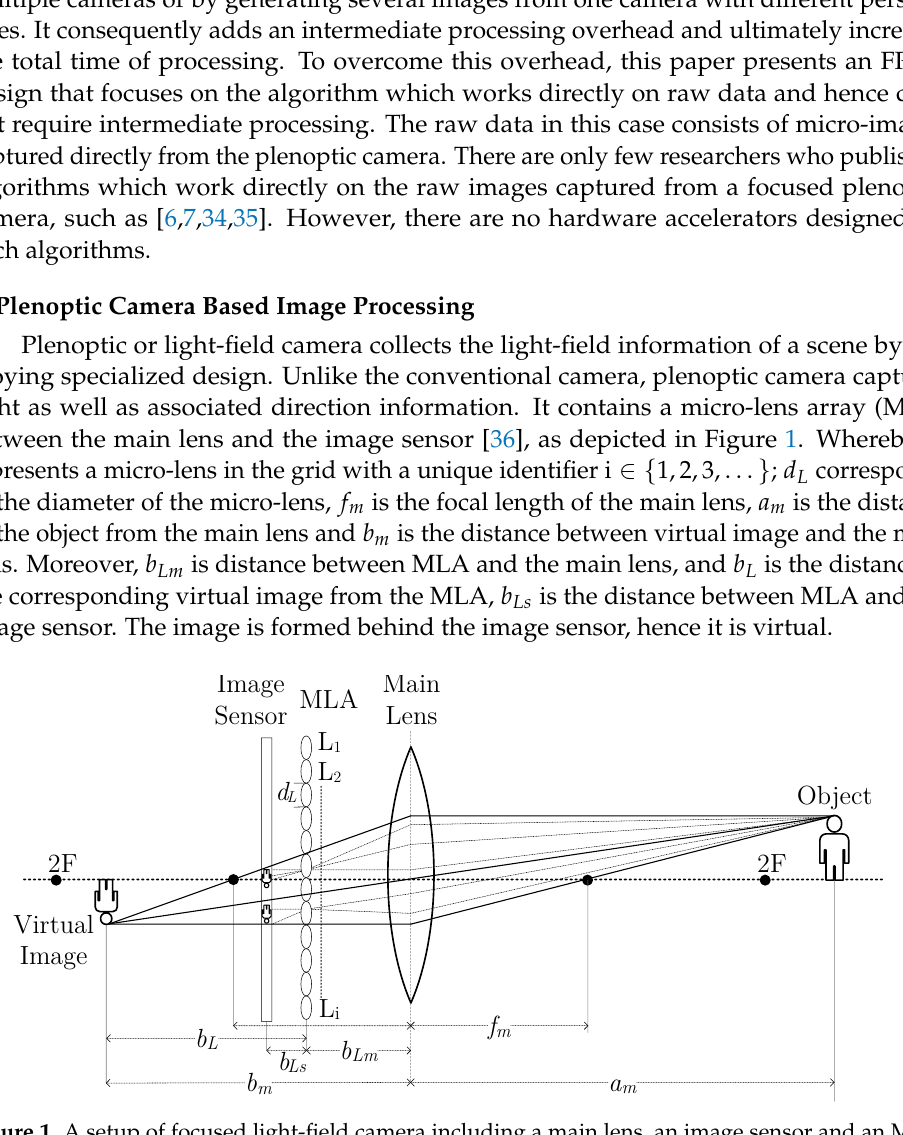
Figure 1. A setup of focused light-field camera including a main lens, an image sensor and an MLA. Within the plenoptic camera, a micro-lens in the MLA focuses a segment of main-lens image on the sensor with its own perspective. These micro-lenses either have similar focal lengths, or they consist of different focal lengths (multi-focus) [37]. Hence, each micro-lens captures a part of the scene corresponding to its position and perspective. As a